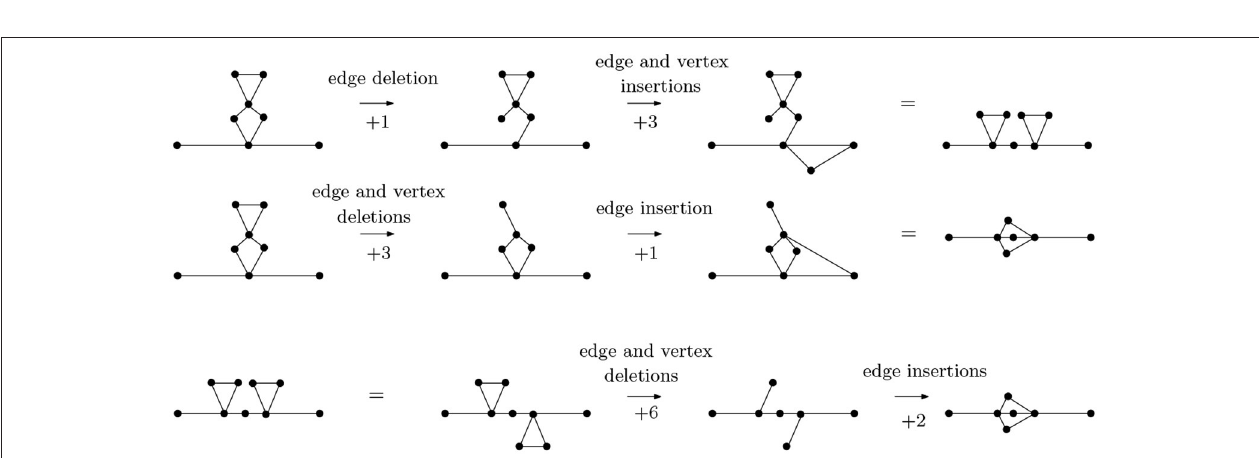
FIGURE 6 | The graph edit distance (with uniform costs) between a molecule with two contacts in series arrangement and a molecule with contacts in parallel arrangement is 4, as is the graph edit distance between a molecule with two contacts in parallel arrangement and a molecule with contacts in cross arrangement. The graph edit distance between molecules with contacts in series and cross arrangements is 8. It is not too difficult to see that the paths of distance 4 from P - to S -type arrangements and from S - to X -type arrangements are minimal, that the distance from an S - to an X -type arrangement is no less than 8 can be seen through detailed considerations of the possibilities of removing vertices (and edges) from a graph with 9 vertices and 10 edges (the S -type) to obtain a graph with 7 vertices and 8 edges (the X -type). For instance, removing two vertices connected to four edges each would already account for a graph edit distance of 10, so only certain vertices need to be considered.